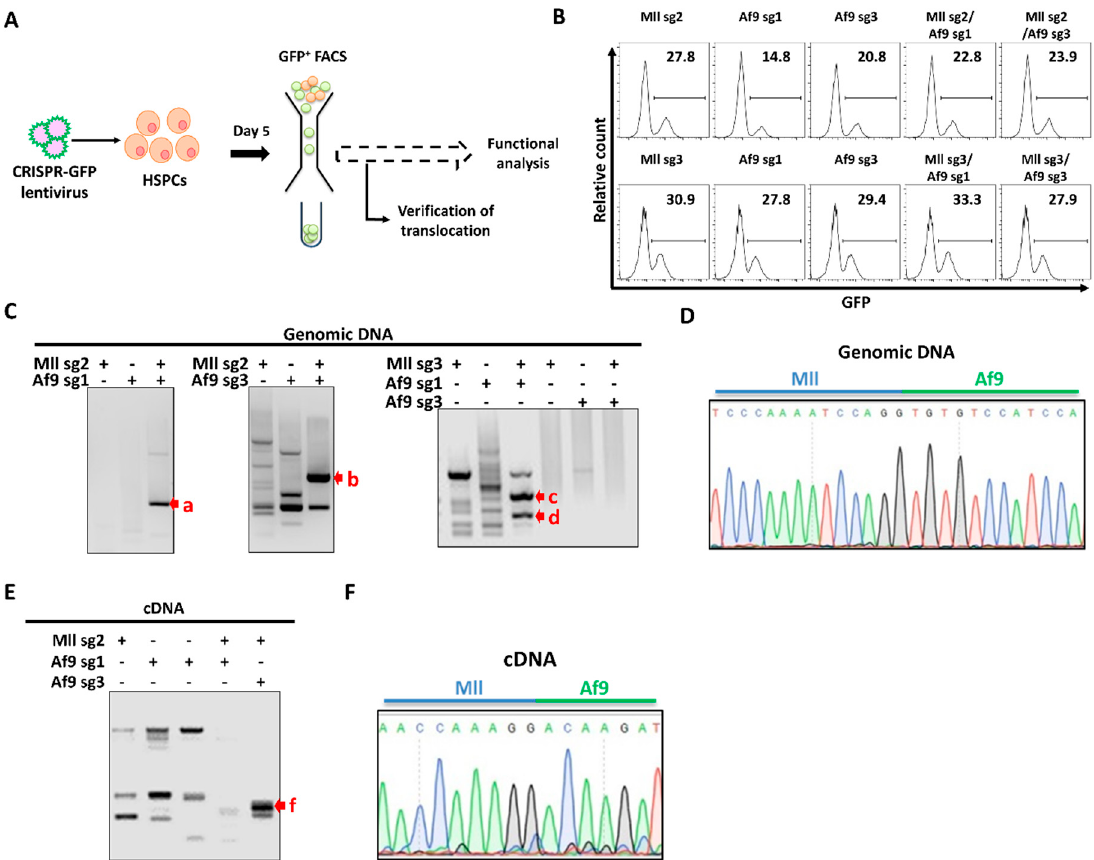
Figure 2. Endogenous generation of MLL-AF9 (MA9) translocation in murine haematopoietic cells: ( A ) Workflow schematic for generation of t(4;9) translocated 32D HSPCs. Cells were transduced with single or dual CRISPR / Cas9 lentivirus and sorted for GFP at day 5 for downstream analysis. ( B ) Flow cytometry histograms showing percentage of GFP + cells at day 5 post-transduction. ( C ) Validation of